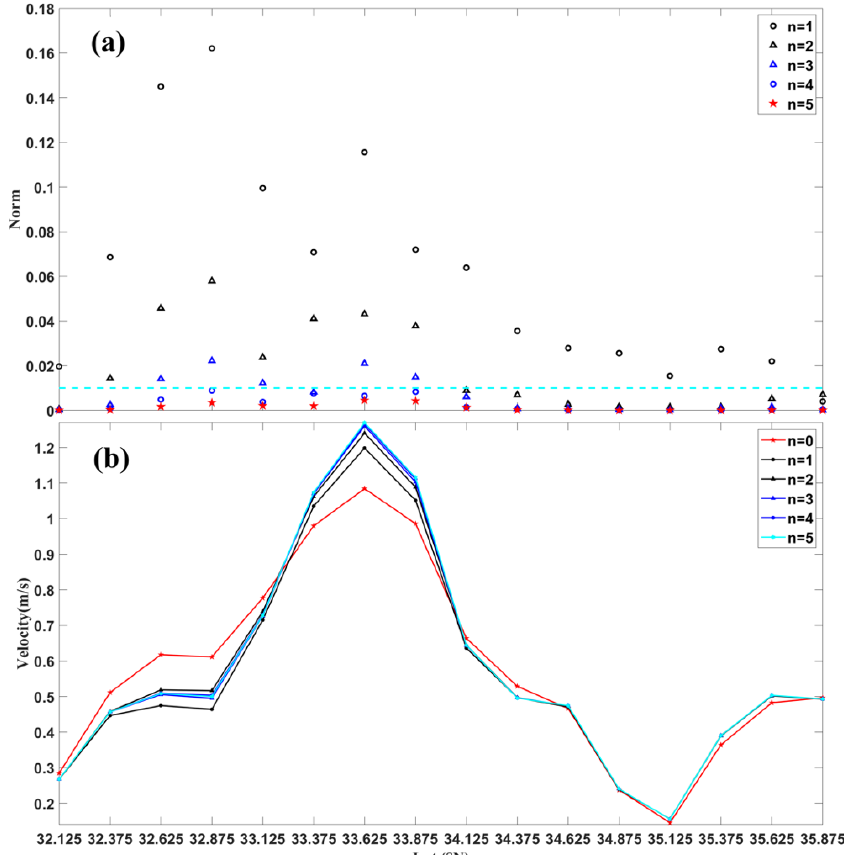
Figure 3. Results of the iterative algorithm applied to the test of a curved path of the Kuroshio Extension region where ( a ) is the change of the norm along the blue dashed line in Figure 2 (norm value = 0.01), and ( b ) is the current velocity obtained by each iteration along the blue dashed line in Figure 2; unit: